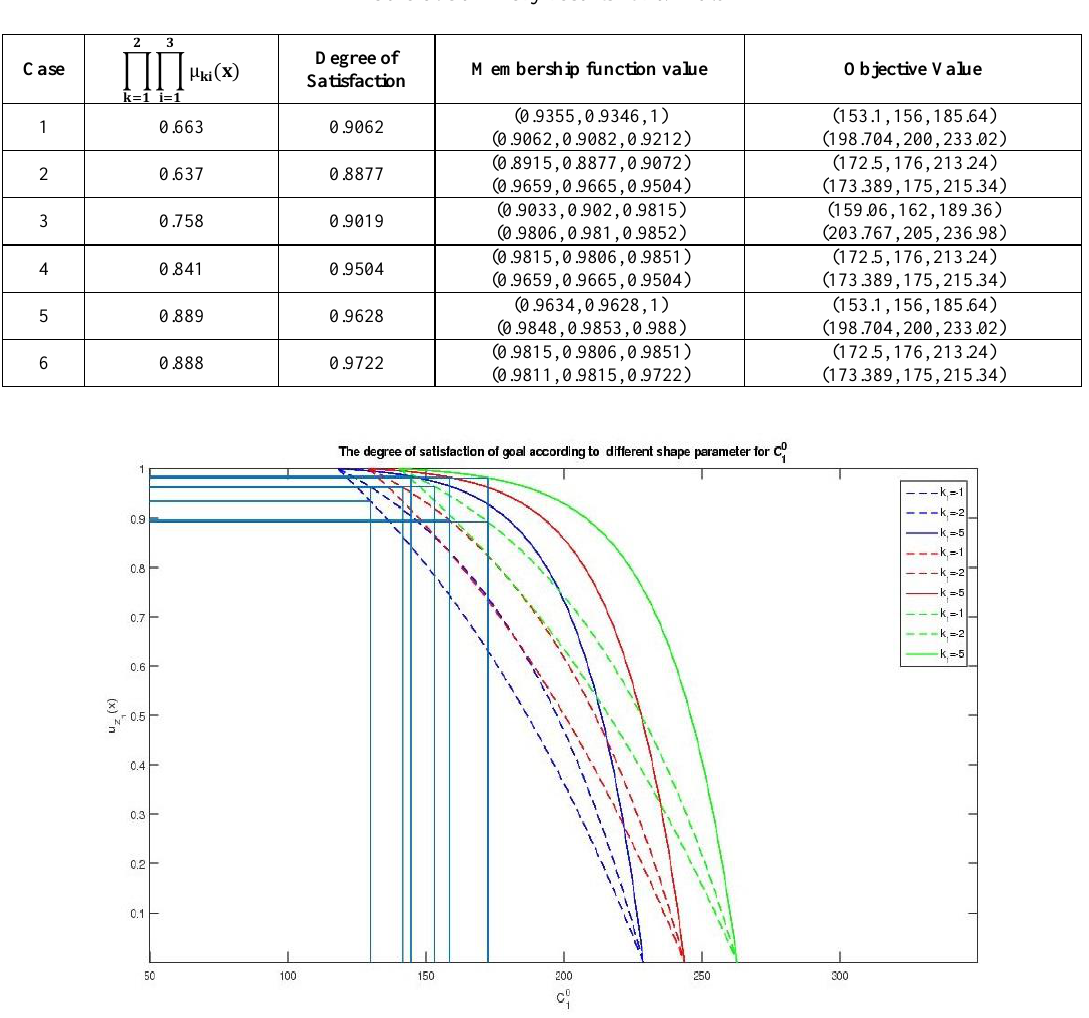
Figure 2. The degree of satisfaction according to different shape parameter for α =0.1